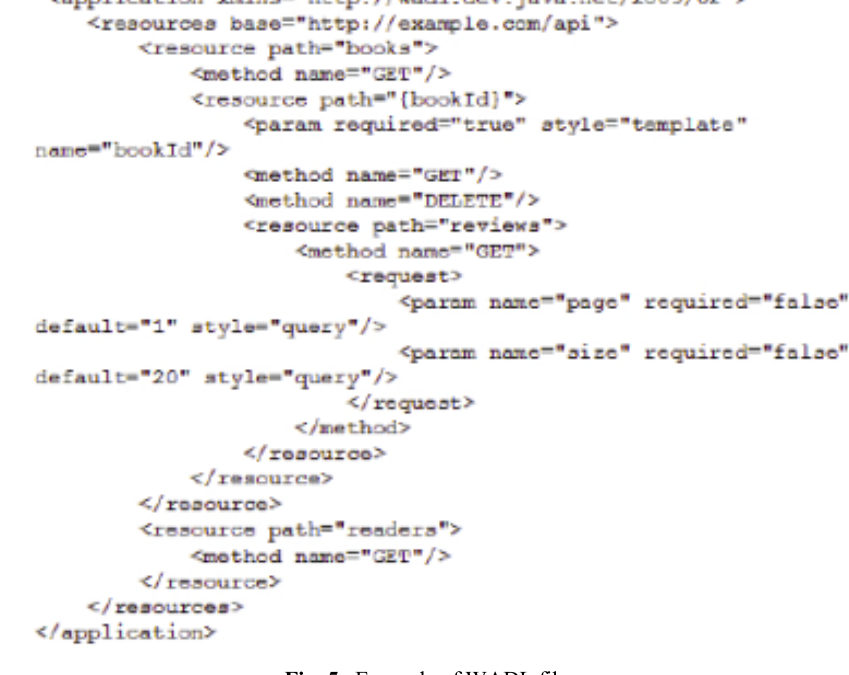
Fig. 5. Example of WADL